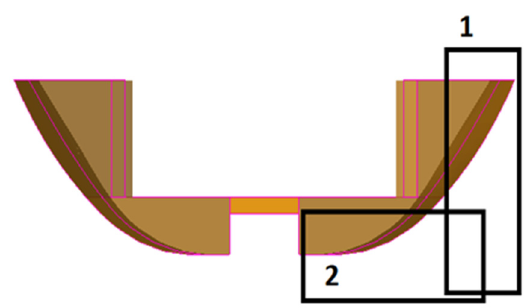
Figure 5. Void Space 3 of the RoPax EMSA2.